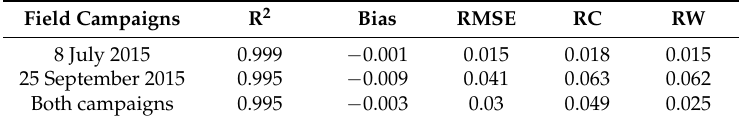
Table 4. Performance metrics of empirical transfer function. Positive bias indicates overestimation of the transfer function estimates. RC stands for cross-validated RMSE; RW stands for weighted